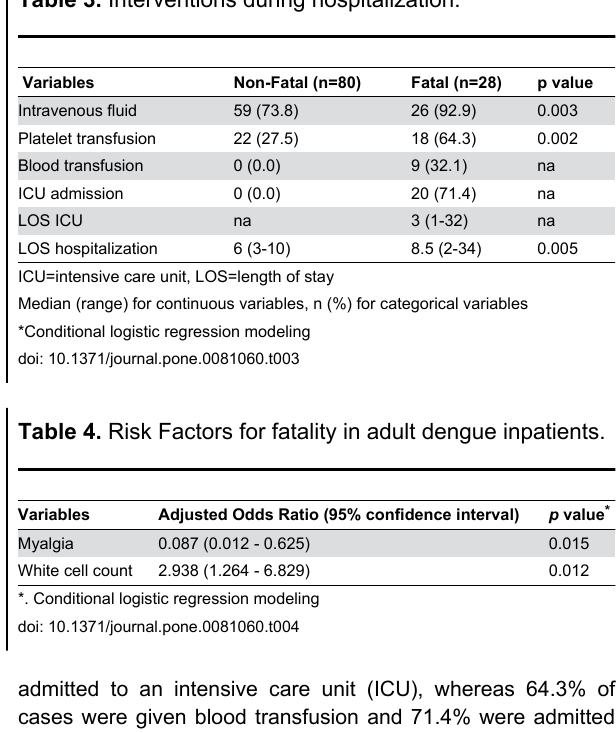
Table 3. Interventions during hospitalization.